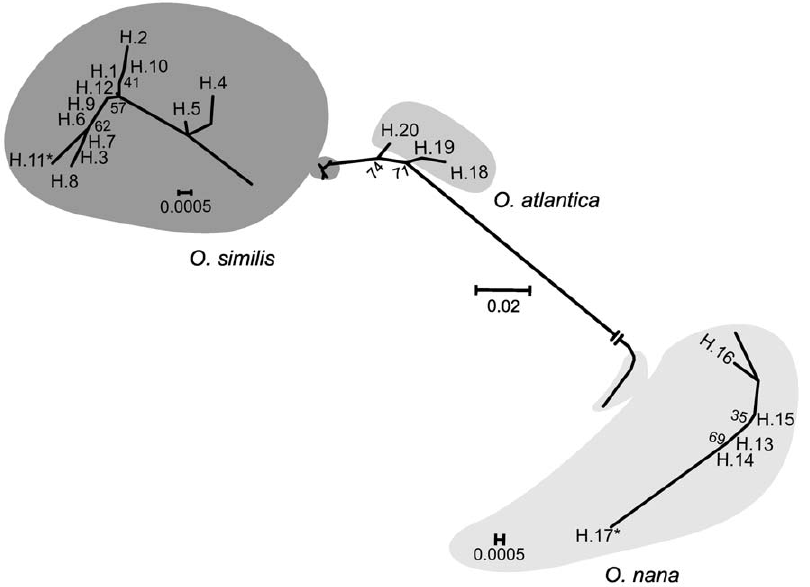
Figure 2. Relationships among the three Oithona species based on 28S rDNA. Unrooted Neighbor-Joining analysis under the Jukes-Cantor model, showing relationships among the three Oithona species based on 28S rDNA sequence types of O. similis (H1–H12), O. atlantica (H13–H17) and O. nana (H18–H20). Sequence types found at each species’ type locality are indicated by asterisk (*). Numbers in the nodes indicate the percentage bootstrap recovery after 10,000 repetitions. doi:10.1371/journal.pone.0035861.g002 PLoS ONE |